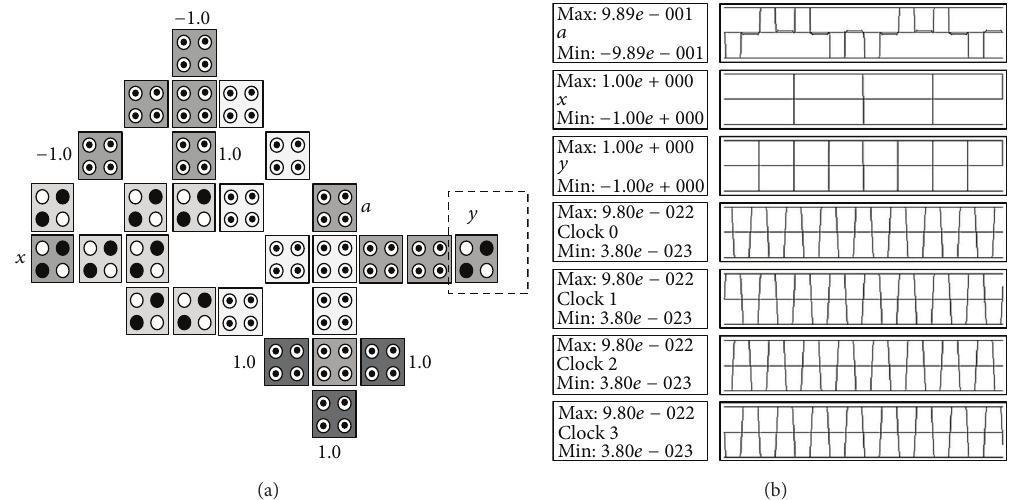
Figure 8: The proposed QCA for the XOR gate: (a) the layout where the added cells to the basic building block are highlighted with dashed line, (b) the simulation results. Table 1: Customization of the 11 configuration cells 𝑥 1 , 𝑥 2 ,...,𝑥 11 of the proposed basic building block where DC denotes device cell, OC denotes output cell, IC denotes input cell, and RC denotes rotate cell. Gates